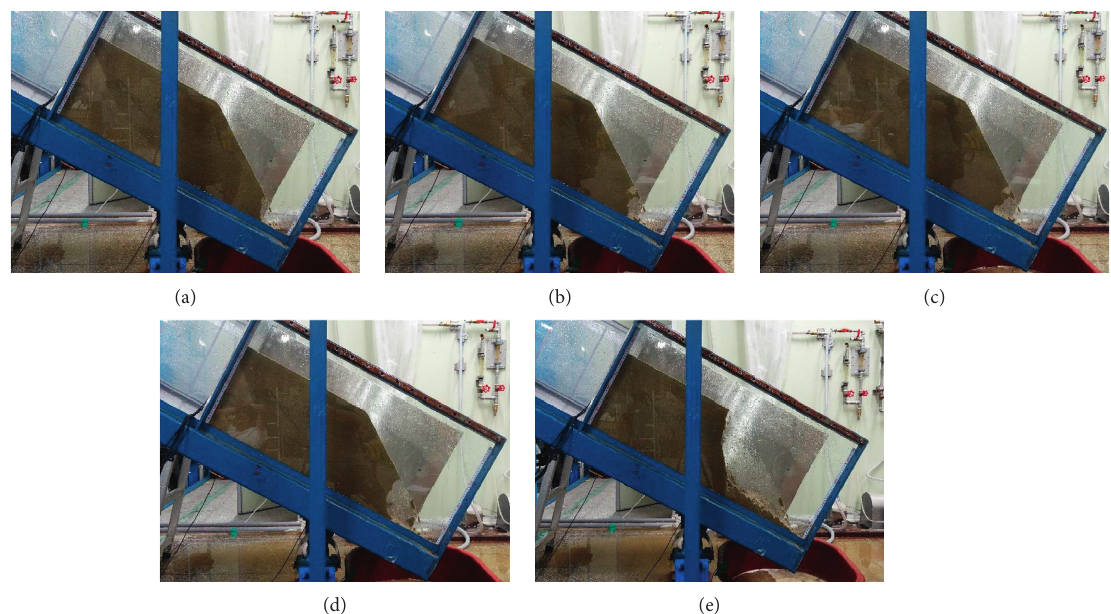
Figure 6: Side view of the slope at each moment of failure: (a) 1st failure (after 95min); (b) 2nd failure (after 103min); (c) 3rd failure (after 114min); (d) 4th failure (after 128min); (e) 5th failure and test completed (after